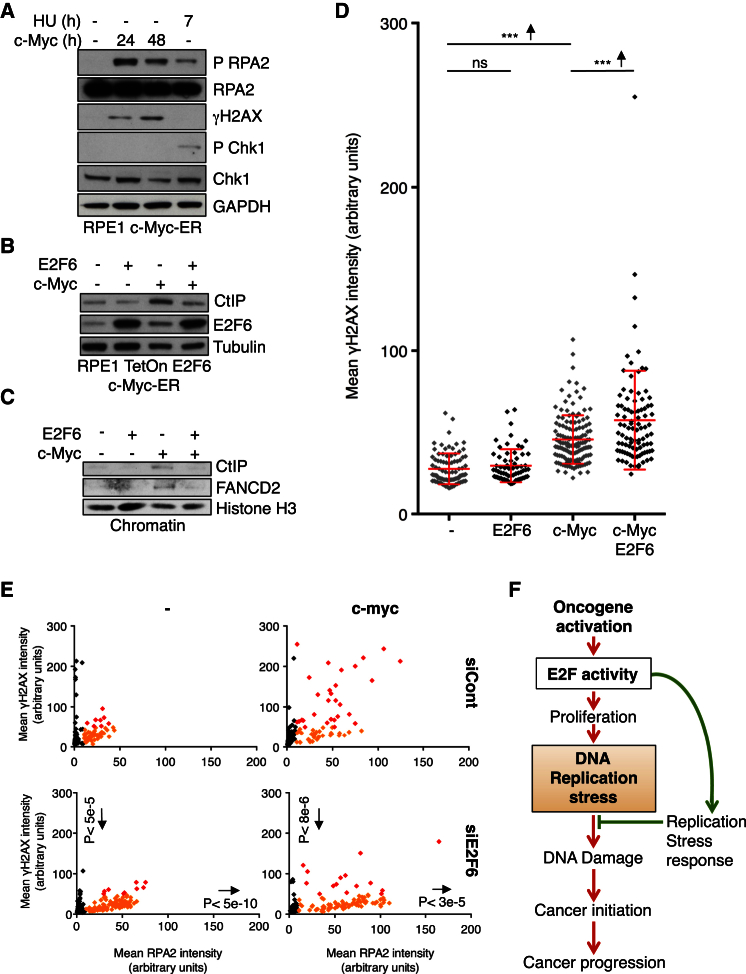
E2F Activity Is Required for Tolerance to Oncogene-Induced RS(A) Western blot of WCE, RPE1 c-Myc-ER cells. Treatment and times shown.(B) Western blot of WCE, RPE1 TetON E2F6 c-Myc-ER cells treatments shown, 72 hr. c-Myc, 4OH-T 200 nM; E2F6, Doxy 1 μg/ml. CtIP is representative E2F target.(C) Western blot of chromatin preparation of RPE1 TetON E2F6 c-Myc-ER cells −/+ c-Myc-ER 4OH-T, 100 nM, 48 hr, E2F6 overexpressed in the last 24 hr (Doxy, 2 μg/ml) as shown. Histone H3 is loading control.(D) Column scatter graph (mean and SD in red) of mean γH2AX intensity in single S phase nuclei, RPE1 TetON E2F6 c-Myc-ER cells −/+ c-Myc-ER 4OH-T, 100 nM, 72 hr, E2F6 overexpressed in the last 24 hr (Doxy, 2 μg/ml) as indicated. Only S phase cells are shown (RPA2 > 20 a.u.). p, significant difference with Wilcoxon. ∗∗∗p < 0.001. Arrows show change of mean.(E) Scatterplot of mean intensity of RPA2 versus γH2AX of single nuclei, RPE1 TetON E2F6 c-Myc-ER cells transfected with siRNA shown −/+ c-Myc-ER induction, 48 hr. Black dots, non-S phase cells (RPA2 < 10 a.u.); orange and red, low and high levels of γH2AX, respectively (arbitrary threshold γH2AX = 50 a.u.). p, differences in S phase cells on both axes with Wilcoxon compared to appropriate siCont control. Arrows show change of mean.(F) Sustained E2F transcription is a key mechanism in the RS checkpoint response. In the context of oncogene-induced RS, whereas increased E2F activity lies at the basis of causing RS, it is also responsible for limiting DNA damage levels resulting from RS.See also Figure S5.